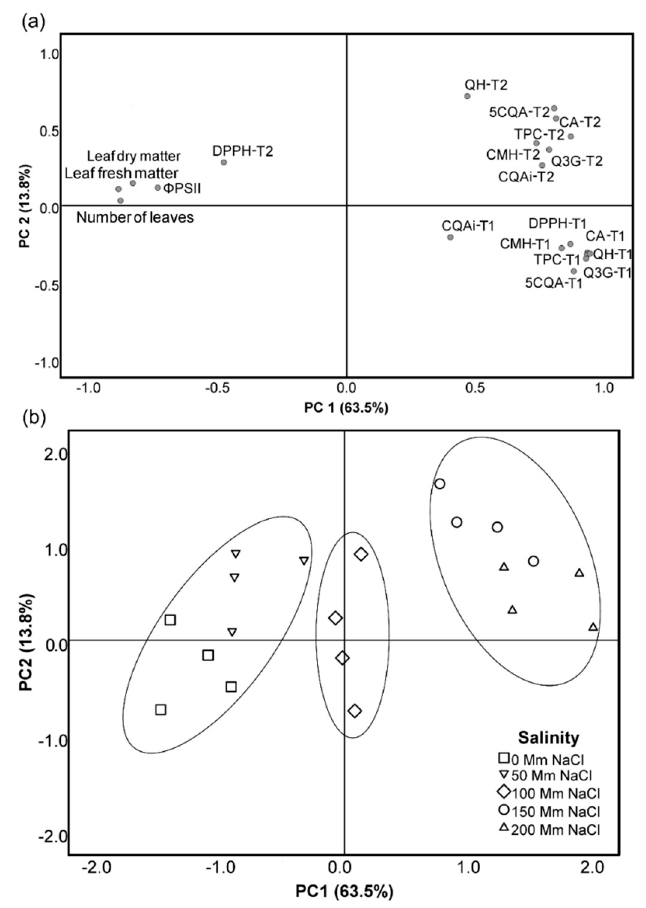
Figure 7. ( a ) Principal component loading plot (PCA) of biomass production, efficiency of photosystem II ( Φ PSII), phenolic compounds, and DPPH antioxidant activity of red lettuce plants ( Lactuca sativa Lollo Rosso cv. ‘CARMOLI’) growing at different saline concentrations in a hydroponic system (0, 50, 100, 150, and 200 mM NaCl). 5CQA: 5-caffeoylquinic acid; QH: quercetin-hexoside; CA: chicoric acid; CMH: cyanidin-malonylhexoside; Q3G: quercetin-3-glucoronide; CQAi: caffeoylquinic acid isomer. T1: sampled after 7 days of NaCl application. T2: sampled after 15 days of NaCl application. The mean value was used in each situation. Percentage values in parentheses indicate the variation explained by each PC. ( b ) Cluster analysis for the experiment. The circles comprise individuals with similar characteristics according to the analysis and should be considered as a visual aid for discrimination of groups.